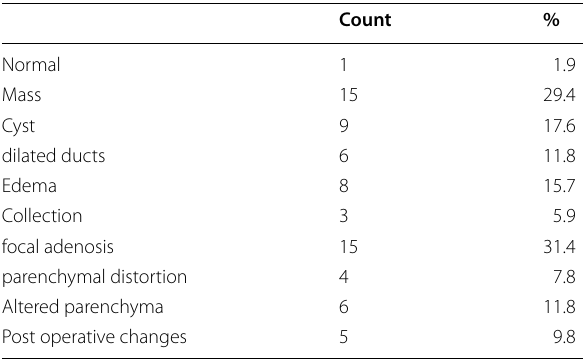
Table 2 The distribution of different pathological entities among the studied population Type of lesion Table 4 Ultrasound findings among studied